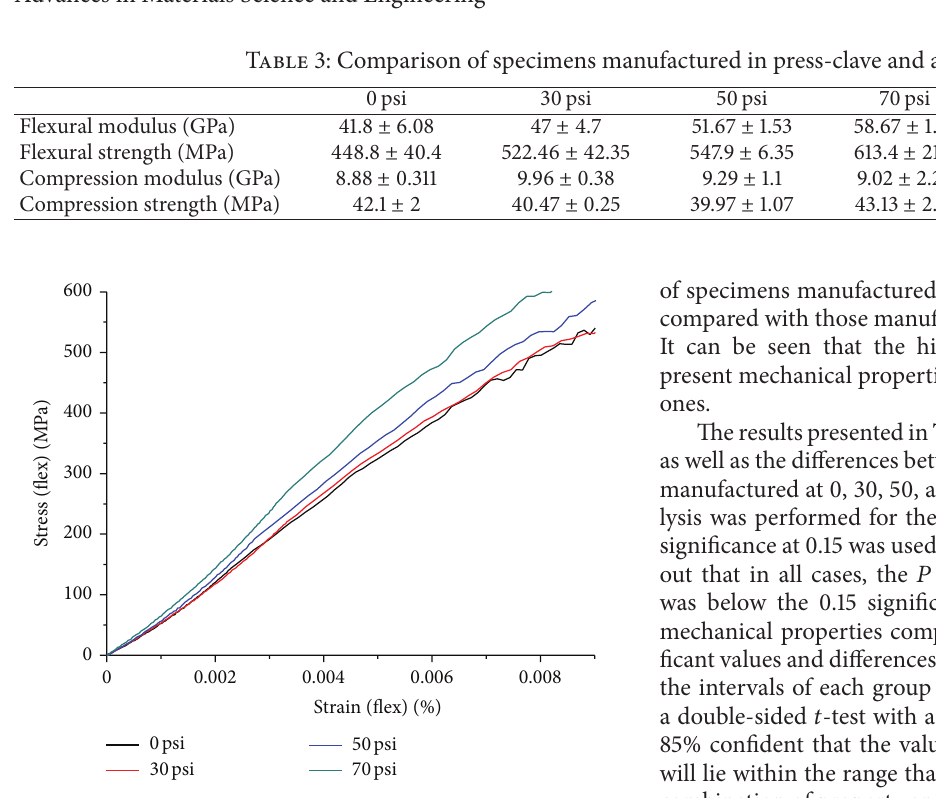
Figure 15: Stress-strain comparison of CFRP specimens manufac- tured under 0, 30, 50, and 70psi derived from flexural